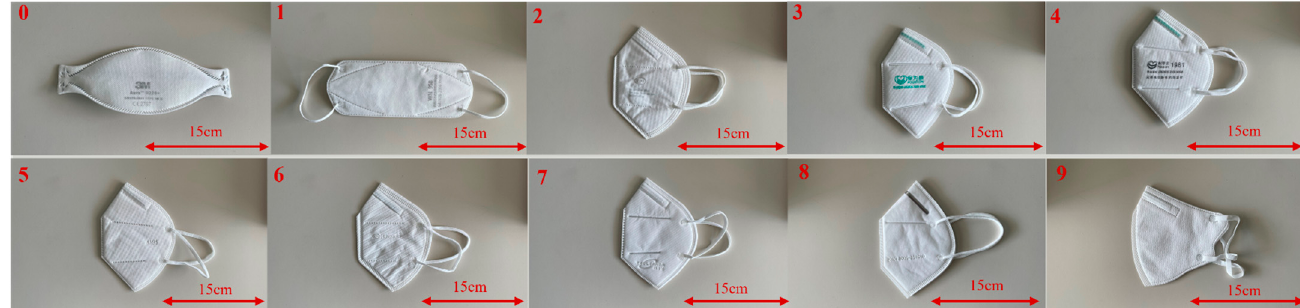
Figure 1. Tested KN95 devices plus FFP2 golden standard mask (0); the sequential numbers are related to Table 1.